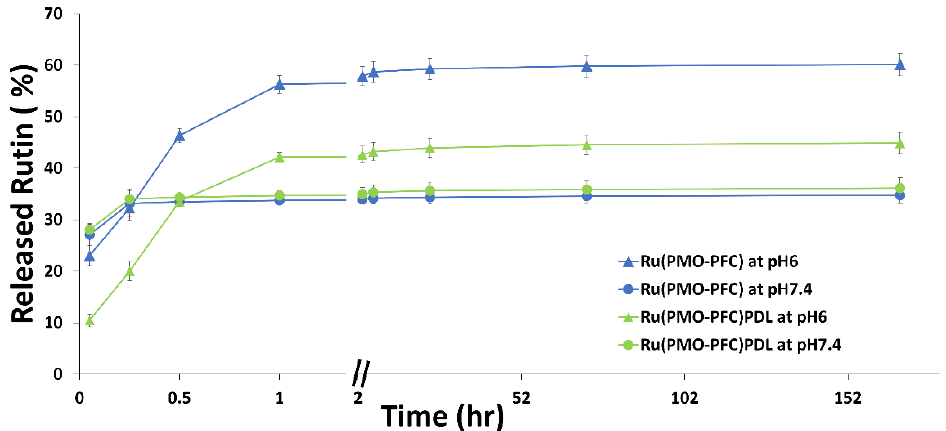
Figure 3. Cumulative percentage rutin release from rutin- and PDL-coated PMO-PFC particles at pH 7.4 and 6.0. Line with triangle markers and round markers are for pH 6.0 and pH 7.4, respectively. The number of experiments is three.